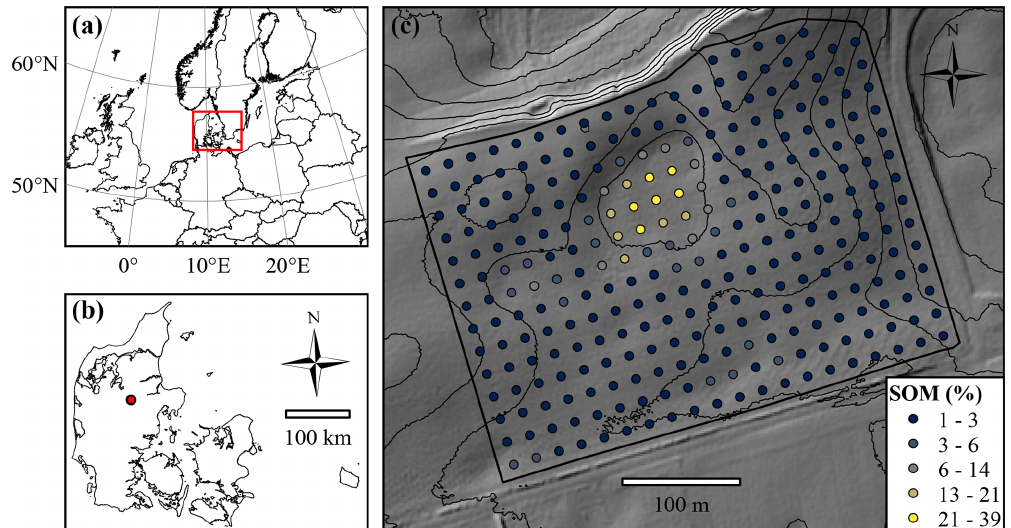
Figure 1. (a) Location of Denmark in northern Europe. (b) Location of the Vindum field within Denmark. (c) Map of the Vindum field, including locations of the samples extracted for soil organic matter (SOM) measurements. The thin black lines are 2m contour lines. The background shows hill shade (northwest; 45 ◦ altitude) based a digital elevation model (DEM) in 1 . 6m × 1 . 6m resolution (National Survey and Cadastre of Denmark, 2012).